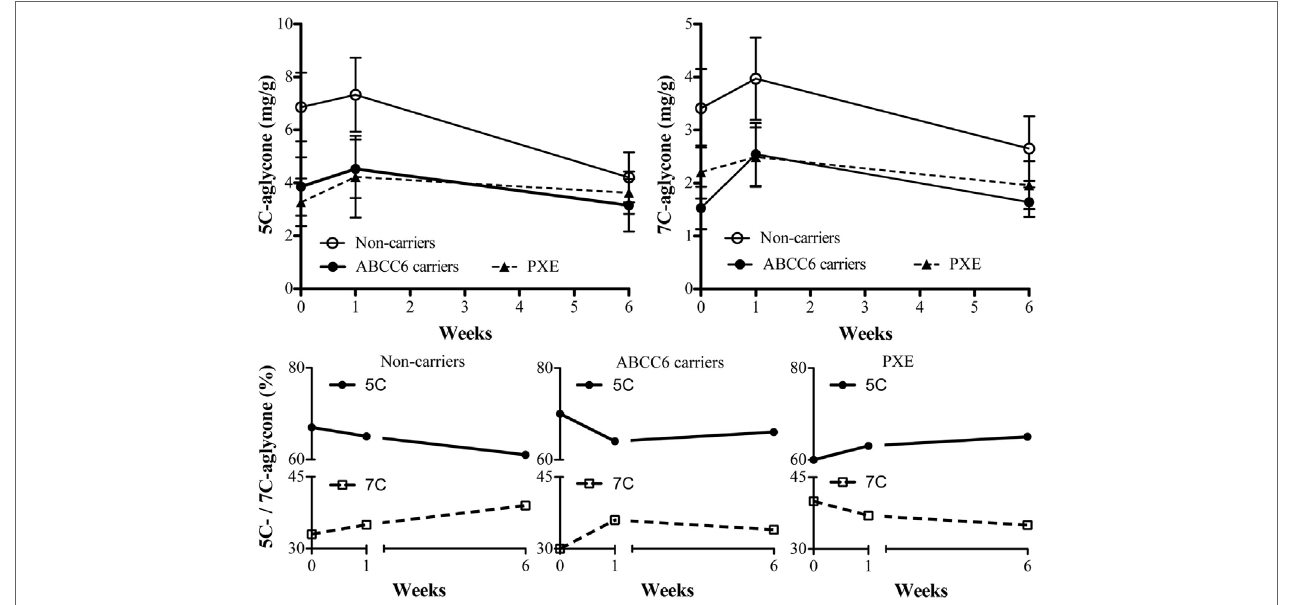
FigUre 1 | 5C- and 7C-aglycone urinary vitamin K metabolites were measured by HPLC (mg/g creatinine) in pseudoxanthoma elasticum (PXE) patients, in heterozygous ABCC6 mutation carriers (ABCC6 carriers) and non-carriers at baseline (week 0) and after 1 and 6 weeks after parenteral phytomenadione administration. Data are expressed as mean values ± SD in upper panels and as percentage of 5C- or 7C-aglycone ratio on total aglycones in lower